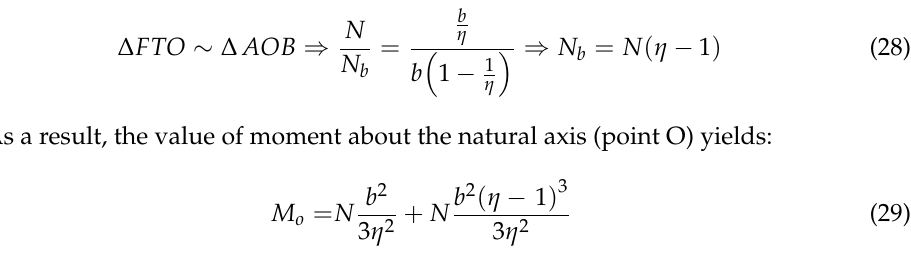
Figure 8. A schematic diagram of a steered tow under the bending load generated by the roller. Regarding Figure 8, the c is equal to 𝑏/𝜂 and from the similarity of two triangles ∆𝐴𝑂𝐵 and ∆𝐹𝑂𝐺 , the value of 𝑁 (the tensile force at the outer edge) can be found: (cid:3029)